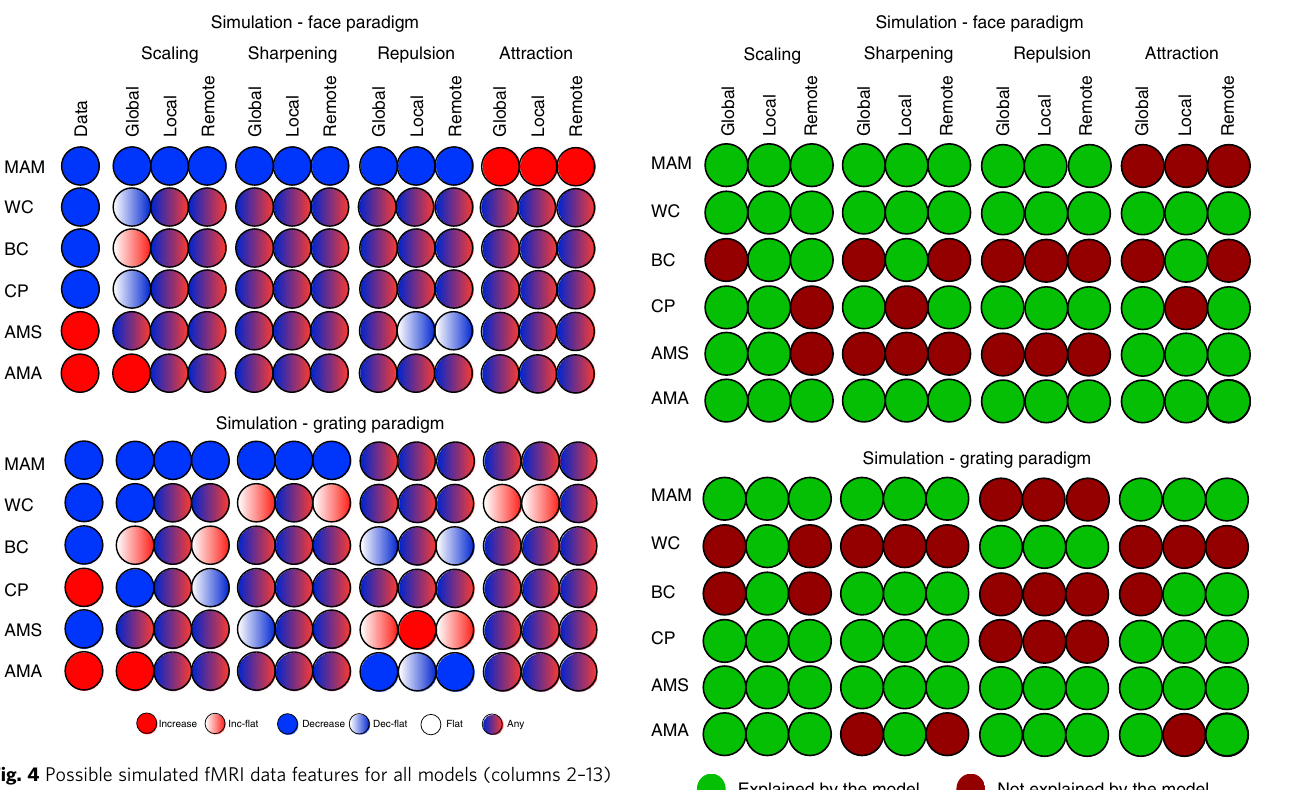
Fig. 4 Possible simulated fMRI data features for all models (columns 2 – 13) for both experimental paradigms when considering all parameter combinations. The fi rst column shows the empirical data features.